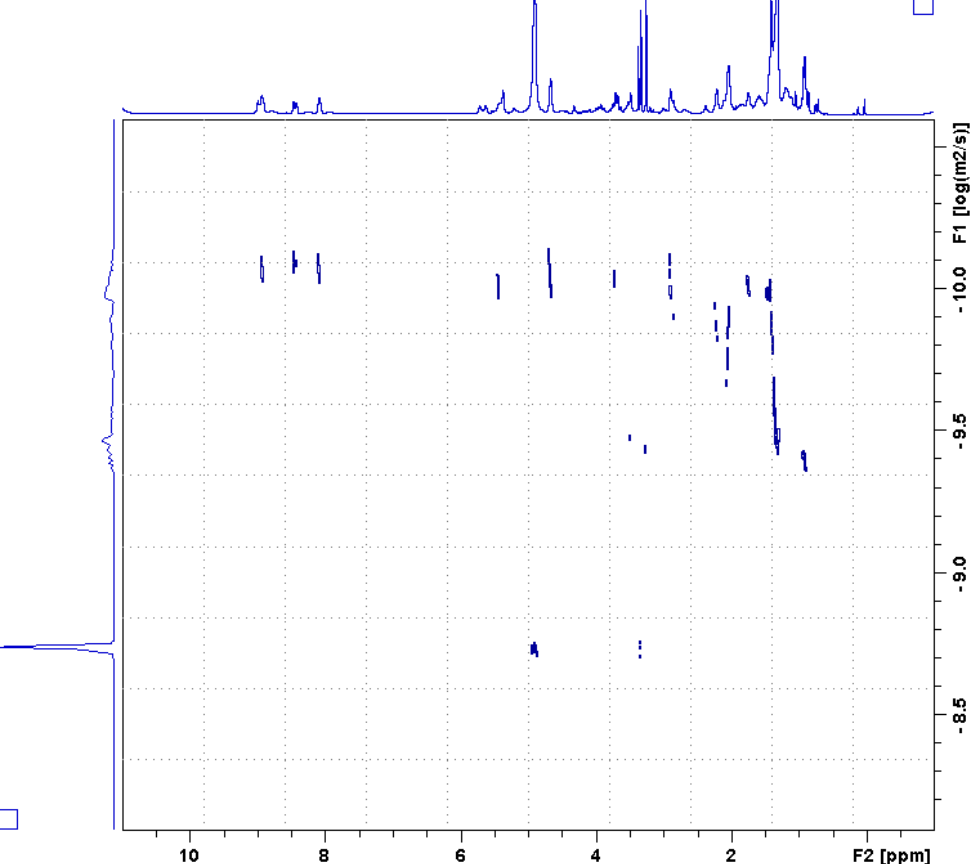
Figure 3. 2D DOSY spectrum of active SPE fraction 2. The horizontal axis corresponds to the 1 H spectrum, while the vertical axis corresponds to the logarithm of the translational diffusion rate, D. Three different species were resolved, the solvent methanol (log(D) = − 8.75 m 2 /s), a lipid like compound (log(D) = − 9.45 m 2 /s), and the cyclic, alkylpyridinium salt compound 1 (log(D) = − 10.05 m 2